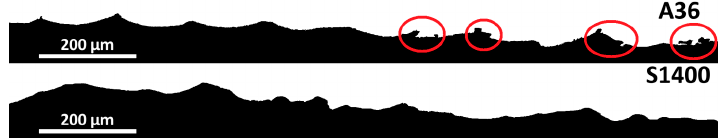
Figure 7. Surface sections of the shot peened samples previously annealed at 1080 °C for 36 s/mm ( above ) and solubilized at 1400 °C for 72 s/mm ( below ): cracks and hook-shaped defects, which act as pitting corrosion initiation sites, have been highlighted.